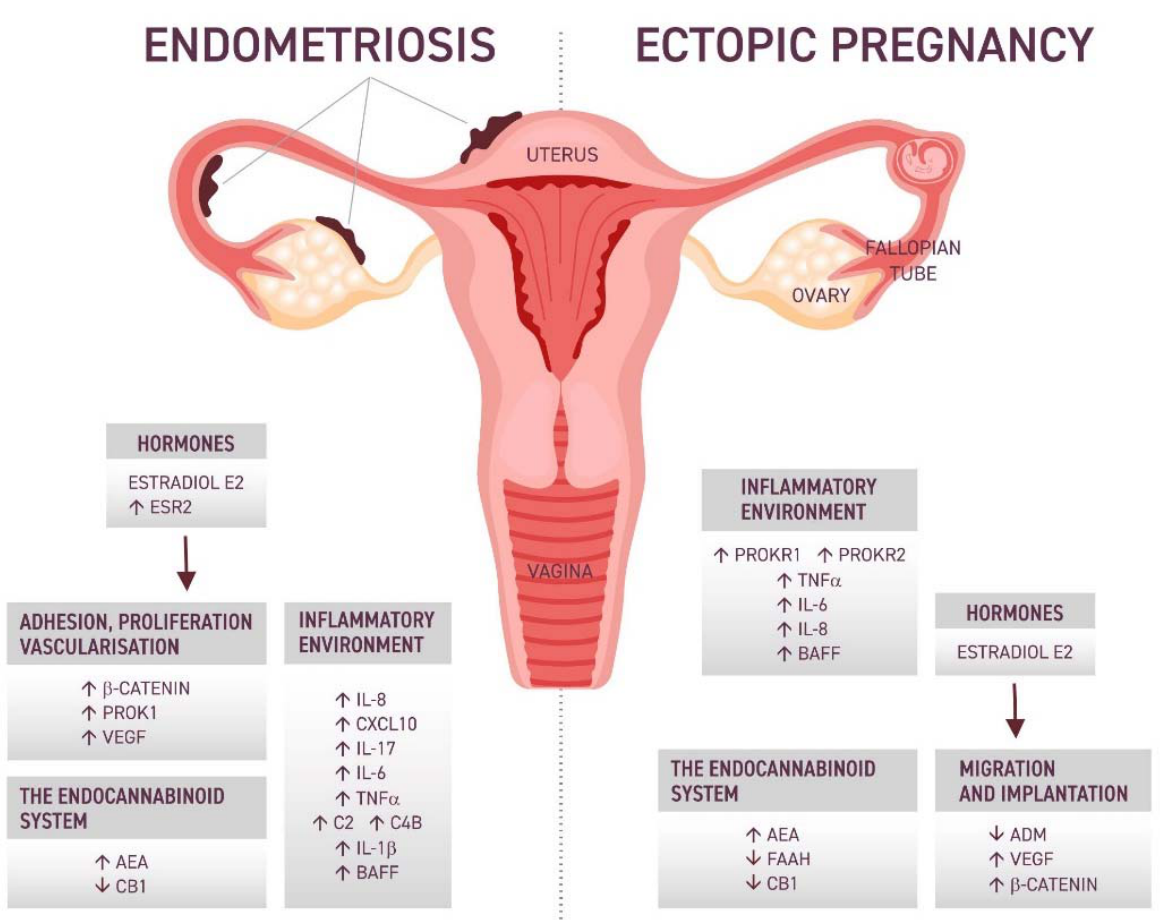
Figure 1. Comparison of potential factors involved in the pathophysiology of EP and endometriosis. ESR2 ‐ estrogen receptor, PROK1 ‐ prokineticin, PROKR1 ‐ , PROKR2 ‐ prokineticin receptors, VEGF ‐ vascular endothelial growth factor, BAFF ‐ B ‐ cell activation factor, AEA ‐ anandamide, FAAH ‐ fatty acid aminohydrolase, CB1 ‐ cannabinoid receptor, ADM ‐ adrenomedullin.